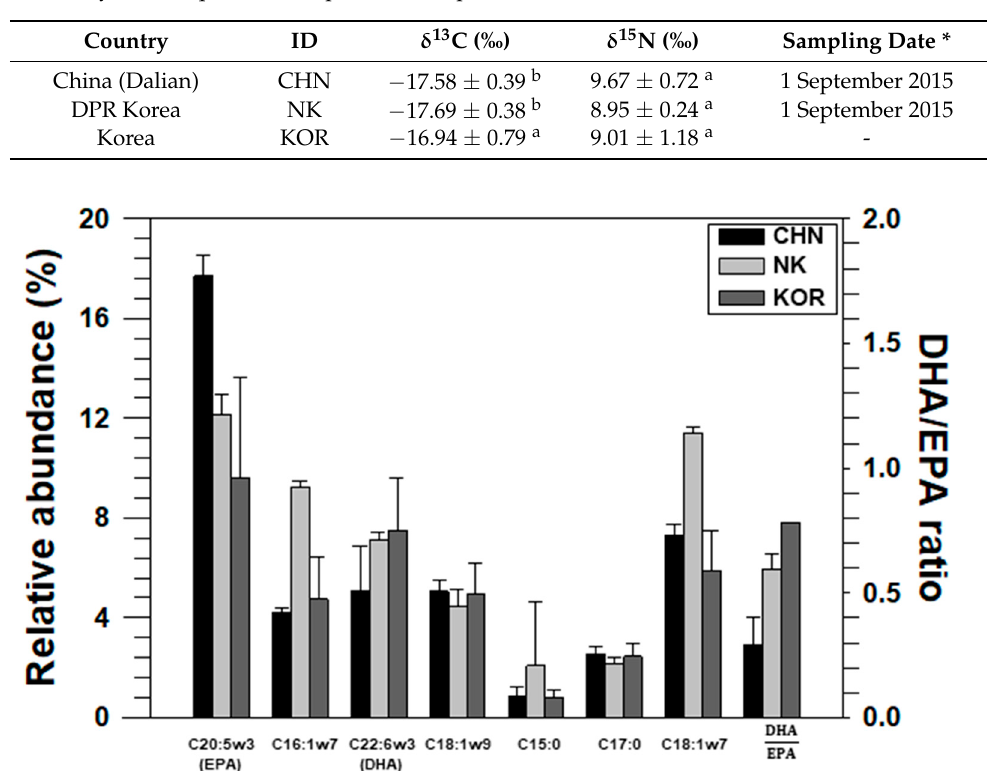
Table 6. Isotopic values ( δ 13 C and δ 15 N) of the Manila clam Ruditapes philippinarum from Korea, China, and DPR Korea. Different letters indicate significant differences of isotope values according to countries (ANOVA, Tukey’s, p < 0.05). * The sampling dates from China and DPR Korea indicate the dates they were acquired in the process of importation into Korea.